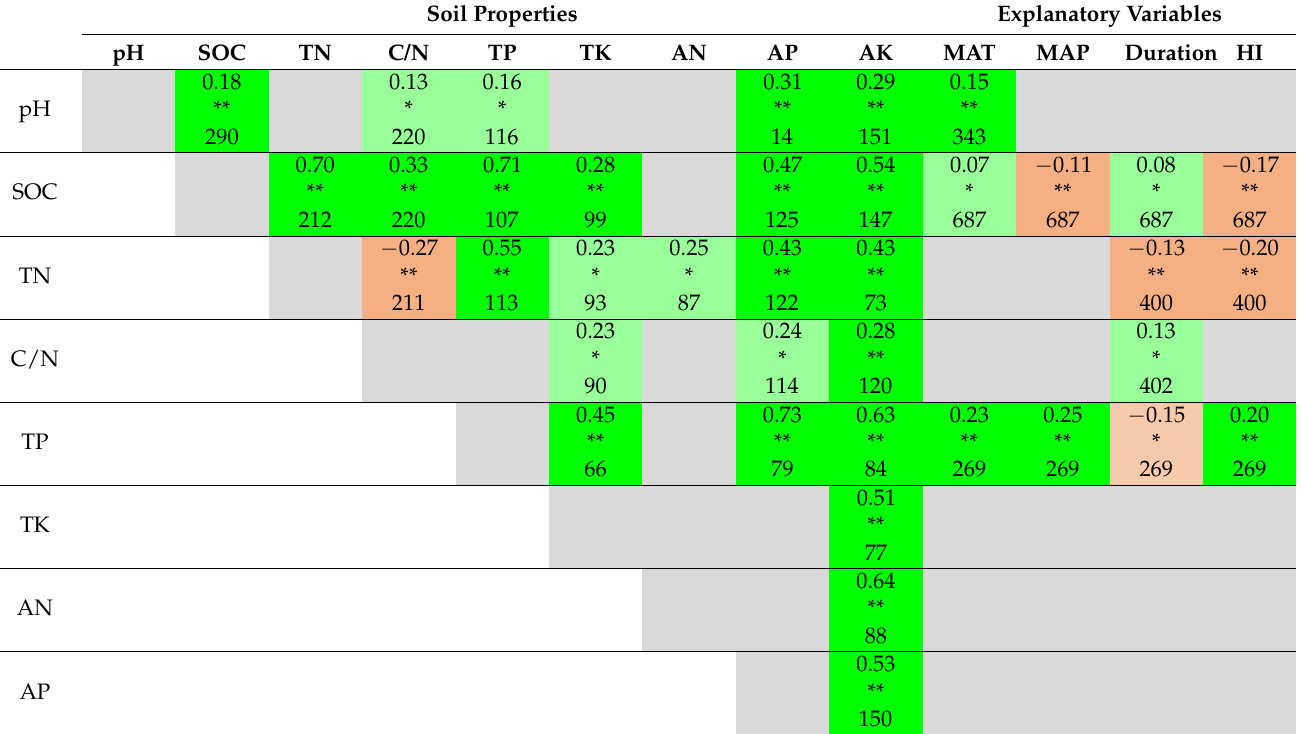
Table 1. Spearman’s rank correlation coefficients between the responses of soil chemical properties and the explanatory variables (MAP, MAT, cultivation duration and HI).